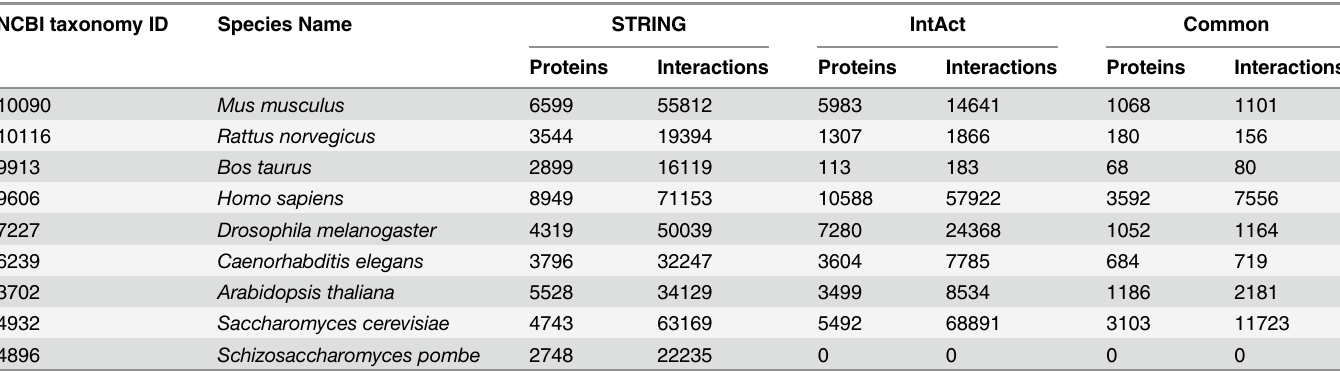
Table 2. PIN size (number of proteins and interactions) for the nine selected species after excluding the components with the size less than 100. NCBI taxonomy